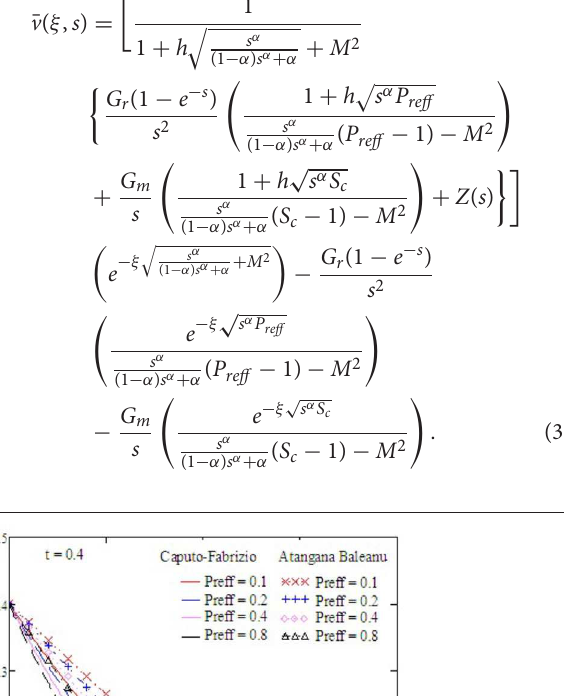
FIGURE 6 | Velocity profiles with altered values of P reff and other parameters are α